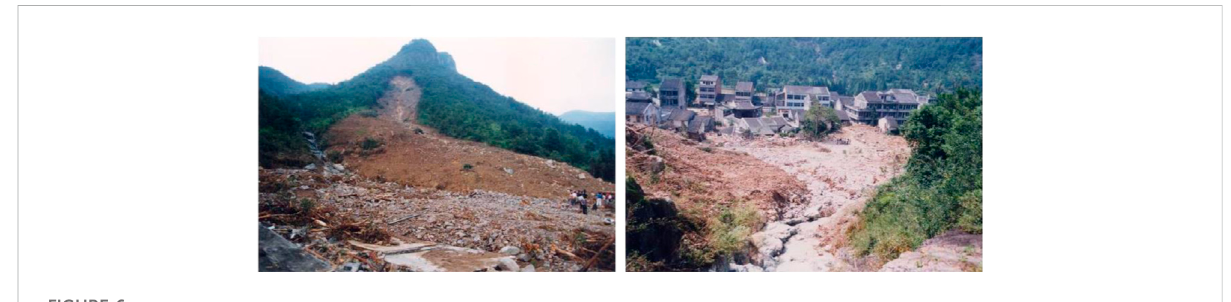
FIGURE 6 Debris fl ow occurrence in September 1999 in Yongjia of Wenzhou.